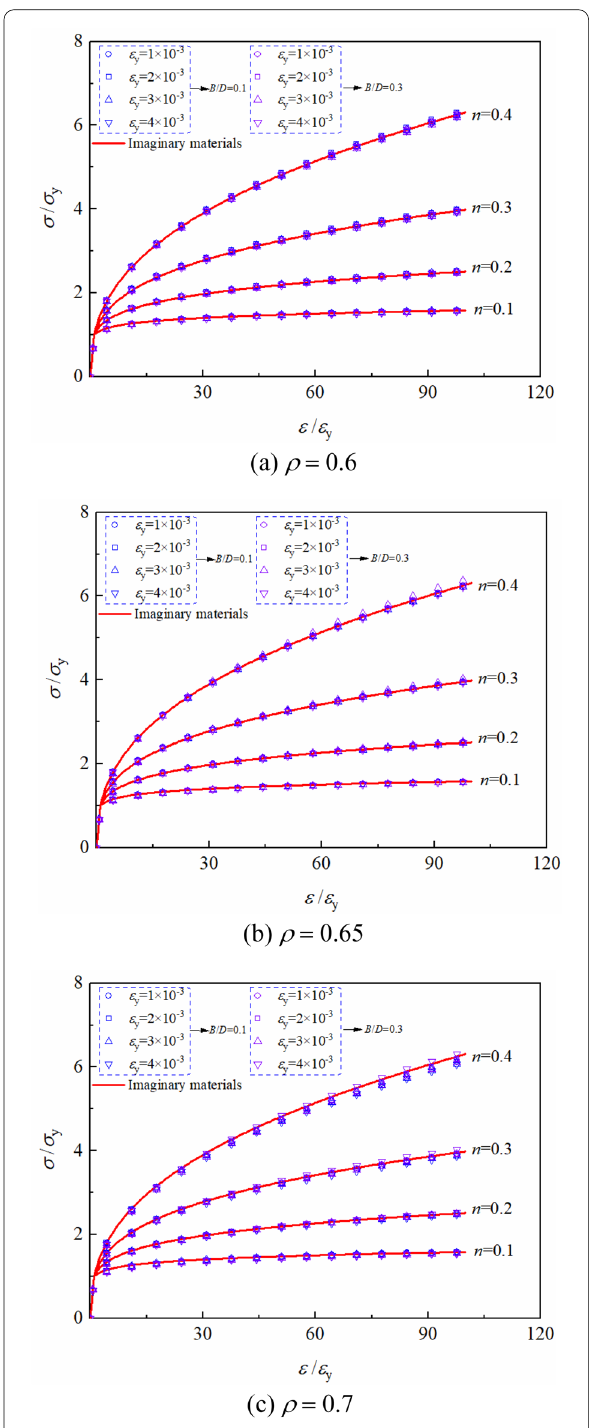
Figure 9 Comparison between the predicted σ – ε curves and those inputted into the FEA program